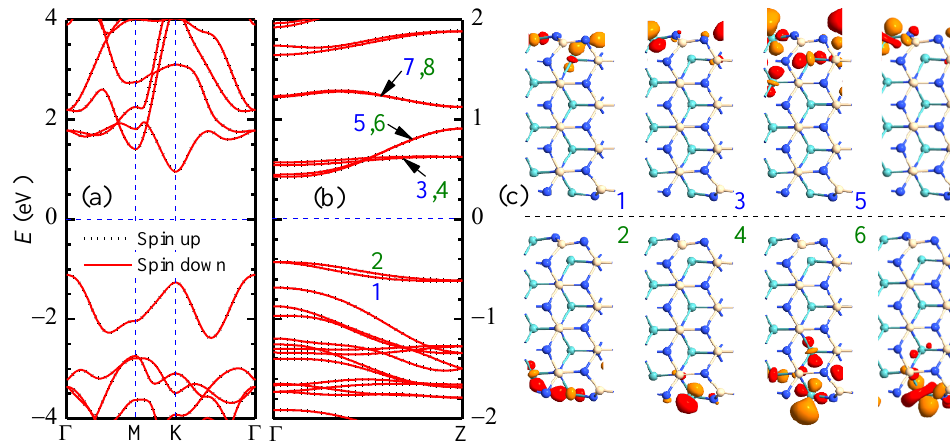
Figure 2. Energy bands of pristine ( a ) MoSiN monolayer and ( b ) aMoSiNNR of n = 4 are presented. The Z-point wave functions of bands 1 – 8 near the Fermi level 0 = for aMoSiNNR are illus- trated in ( c ).